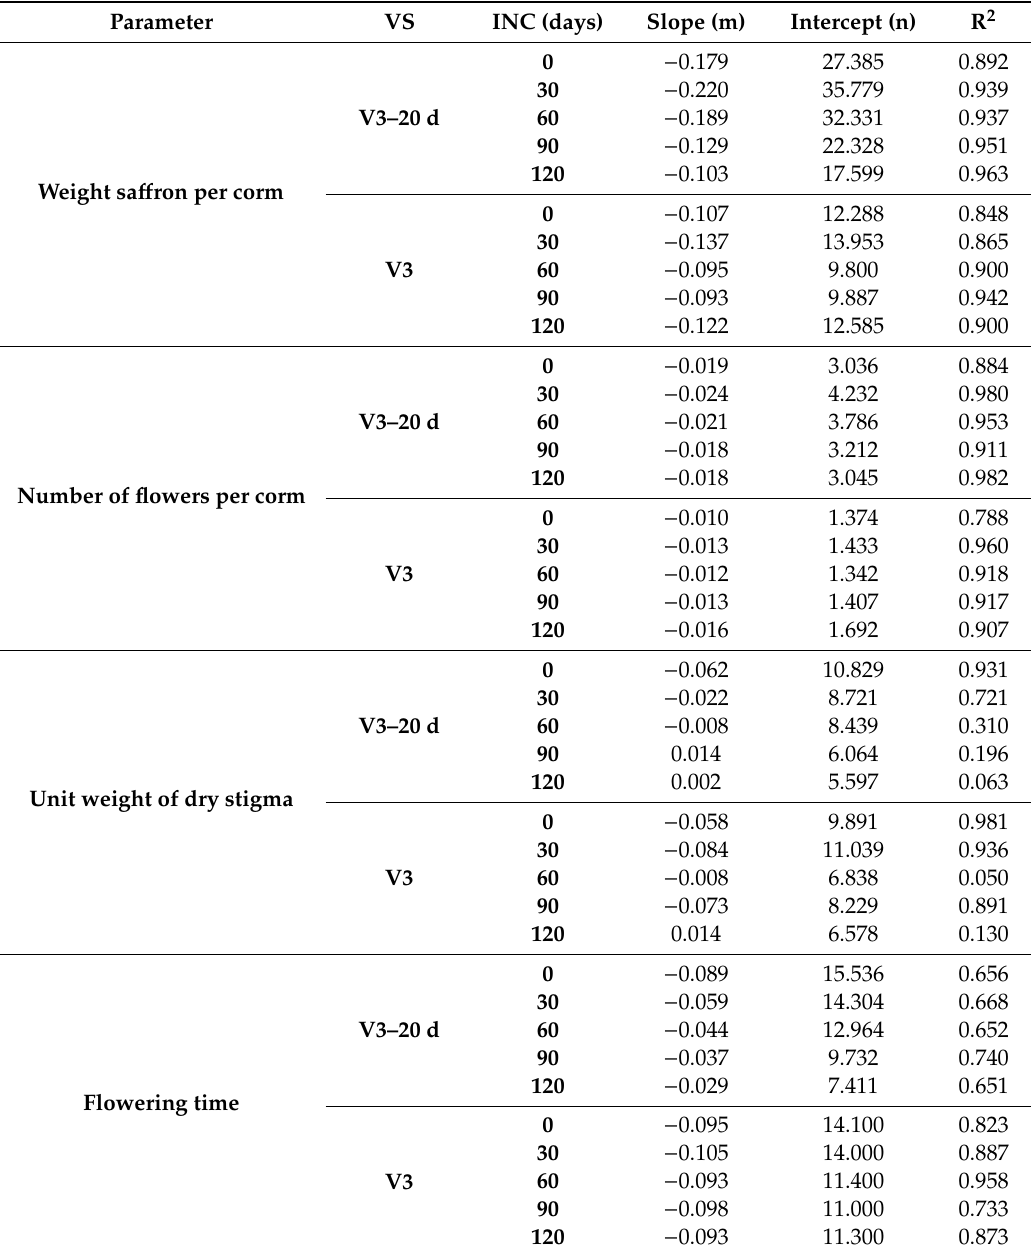
Table 3. Slope, intercept, and correlation coe ffi cient (R 2 ) of the curves adjusted for each studied